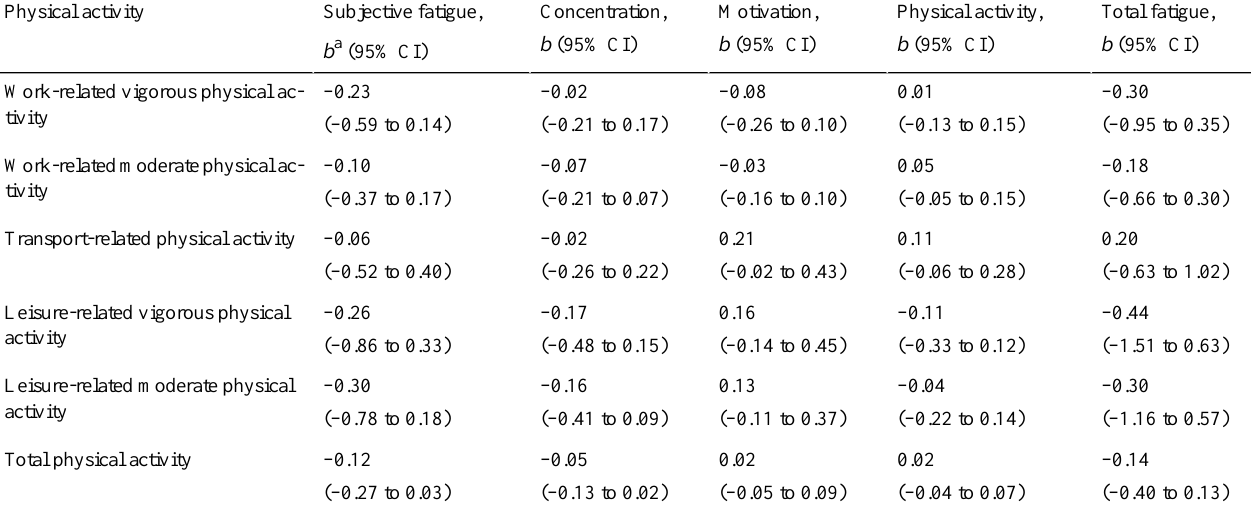
Table 6. Results of multivariable linear regression models assessing associations between absolute changes in workers’ domain-specific physical activity and changes in workers’total fatigue and aspects of fatigue in Japan